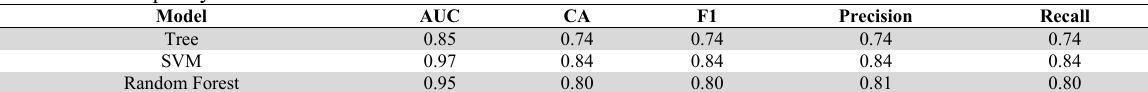
Results of Web quality